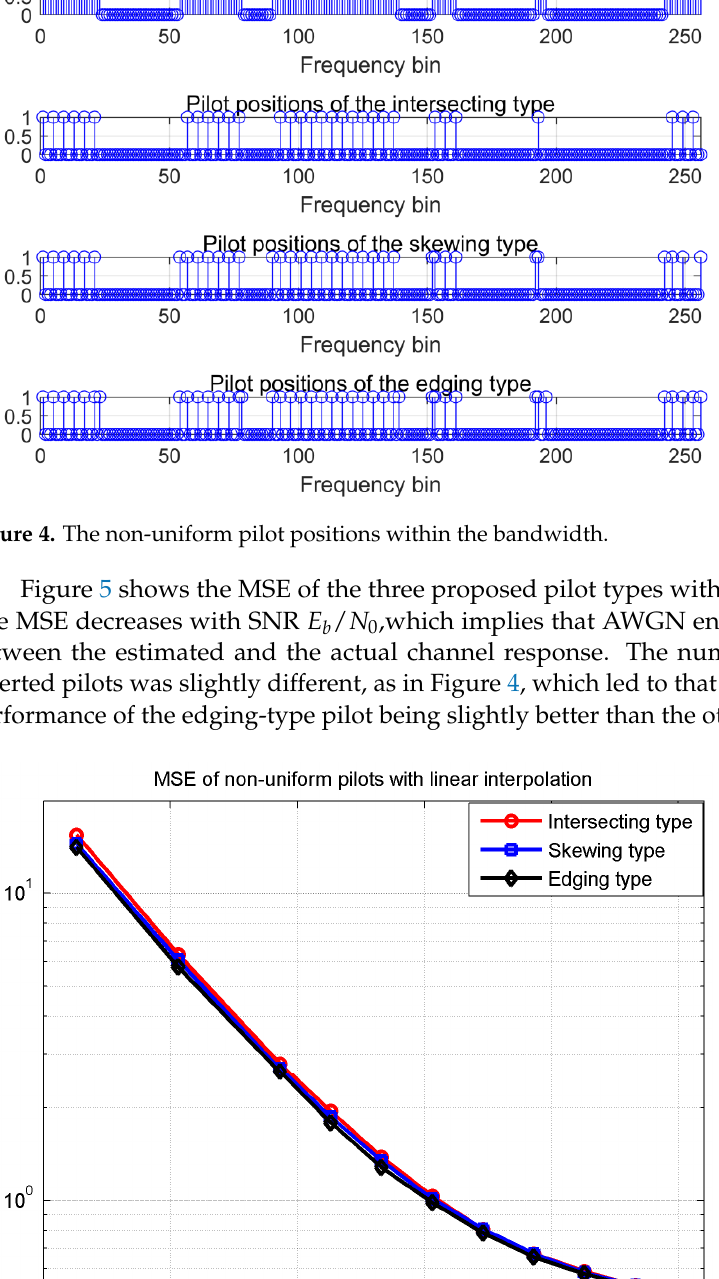
Figure 6. BER of non-uniform pilots with linear interpolation. In Figure 7, the BER performance of the edging type pilots was simulated with dif- ferent parameters. The initial interval between two adjacent pilots determines the initial pilot number; the smaller the interval the more pilots are inserted and the better the BER